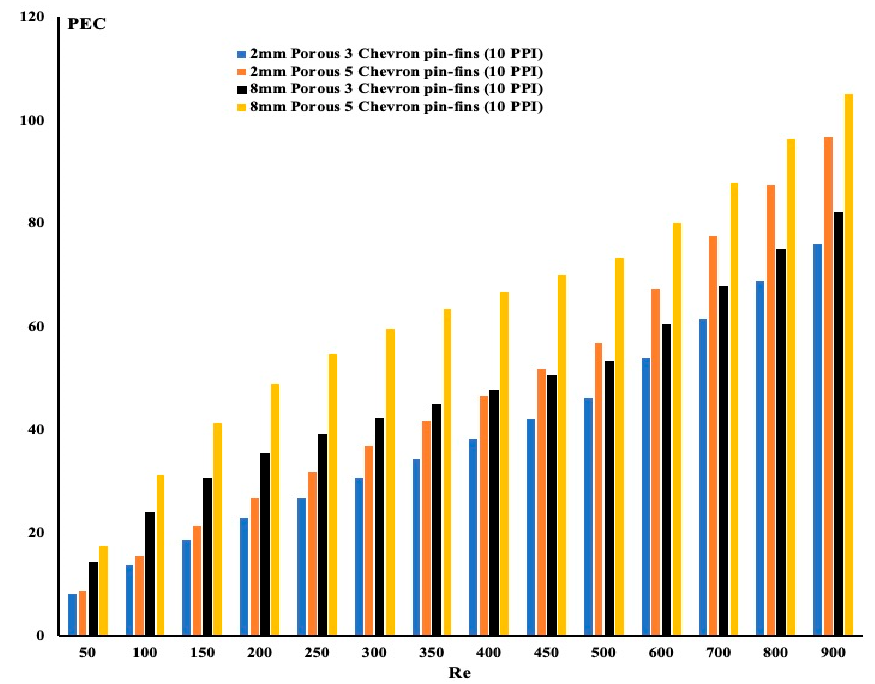
Figure 8. PEC for porous pin-fins with a permeability of 10 PPI.